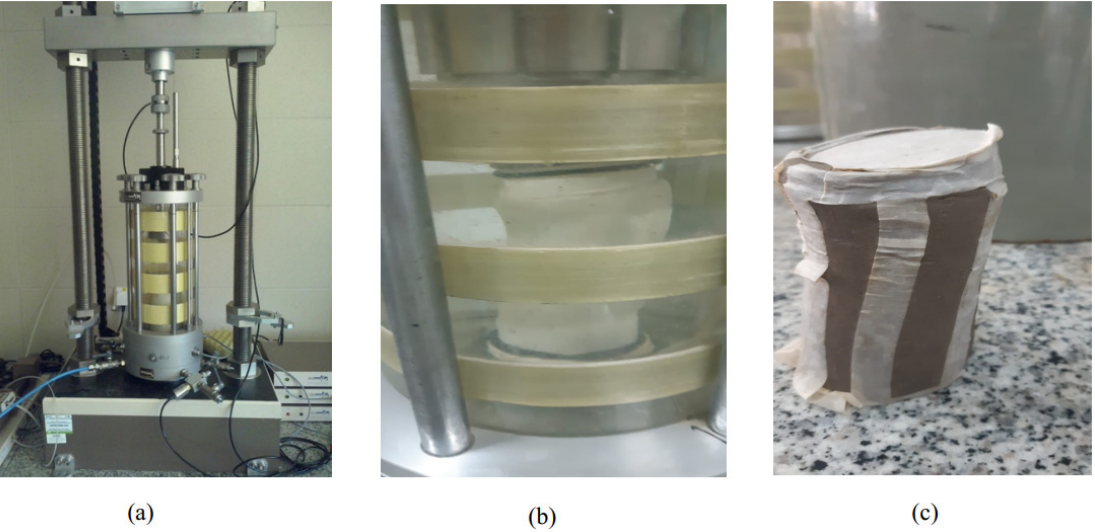
Figure 7. Determination steps for shear parameters (C and Φ ) using a tri-axial apparatus. ( a ) Tria-axial test apparatus; ( b ) Soil sample in tri-axial cell; ( c ) Soil sample at failure.